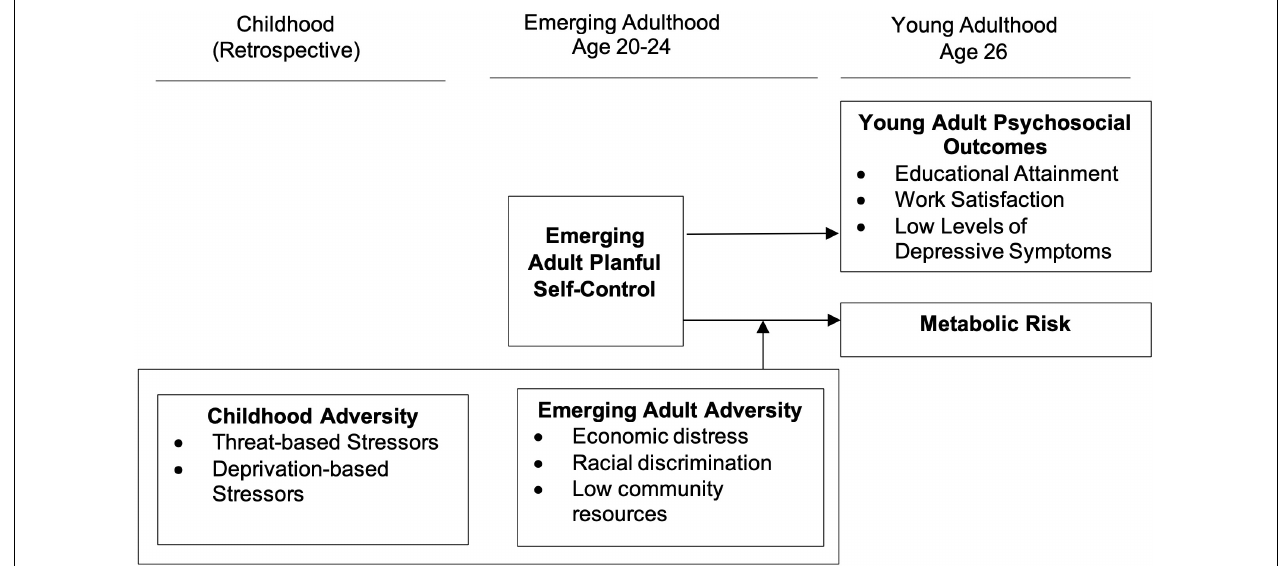
FIGURE 1 | Conceptual model of study